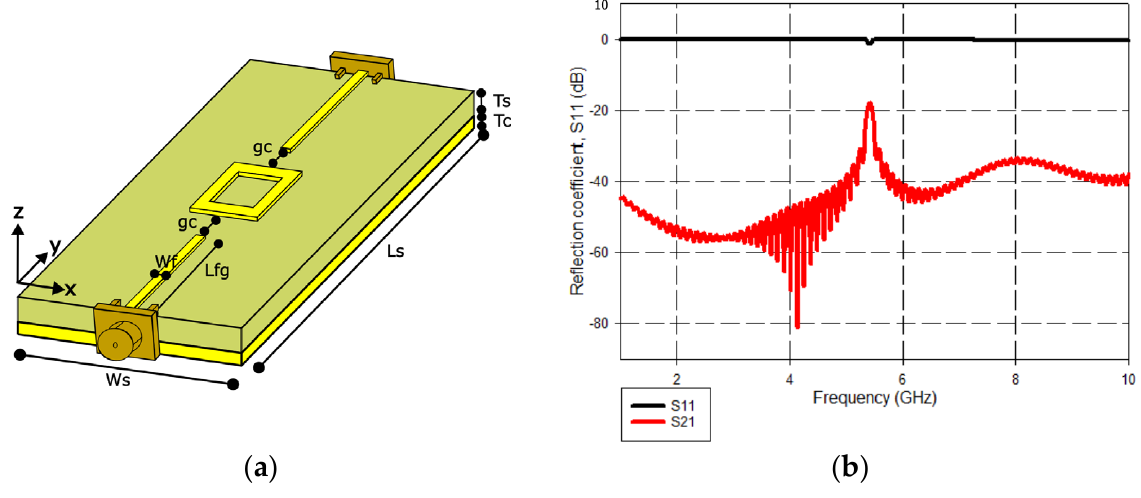
Figure 6. The ( a ) unconnected microstrip feed line structures and ( b ) its scattering parameter re- sponse.